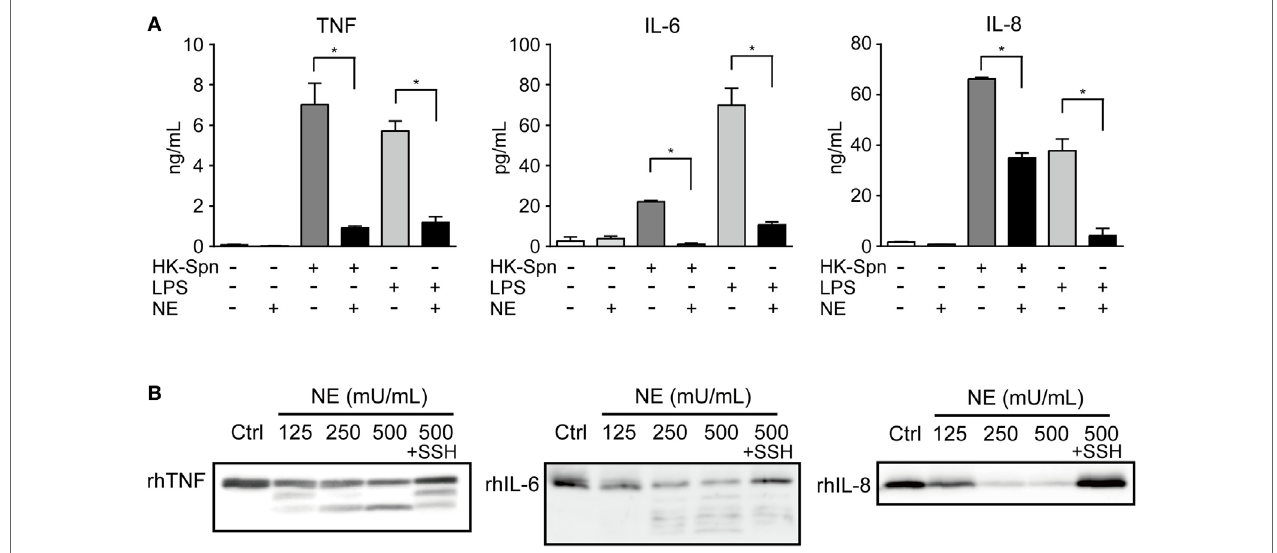
FigUre 4 | Neutrophil elastase (NE) degrades TNF, IL-6, and IL-8 (a) . THP-1-derived macrophages were exposed to hNE (125–500 mU/mL) in the presence or absence of HK-Spn or LPS (100 ng/mL) for 4 h. TNF, IL-6, and IL-8 concentrations in the culture supernatants were determined by ELISA. Data represent the mean ± SD of quadruplicate experiments and were evaluated using one-way analysis of variance with Tukey’s multiple-comparisons test. *Significantly different within the same activation status at P < 0.05. (B) rhTNF, rhIL-6, and rhIL-8 were exposed to hNE (125–500 mU/mL) in the presence or absence of SSH (100 µg/mL) for 3 h and determined by western blot analysis. ELISA, enzyme-linked immunosorbent assay; HK-Spn, heat-killed S. pneumoniae ; LPS, lipopolysaccharide; hNE, human neutrophil elastase; rh, recombinant human; SSH, sivelestat sodium hydrate; IL, interleukin; TNF, tumor necrosis